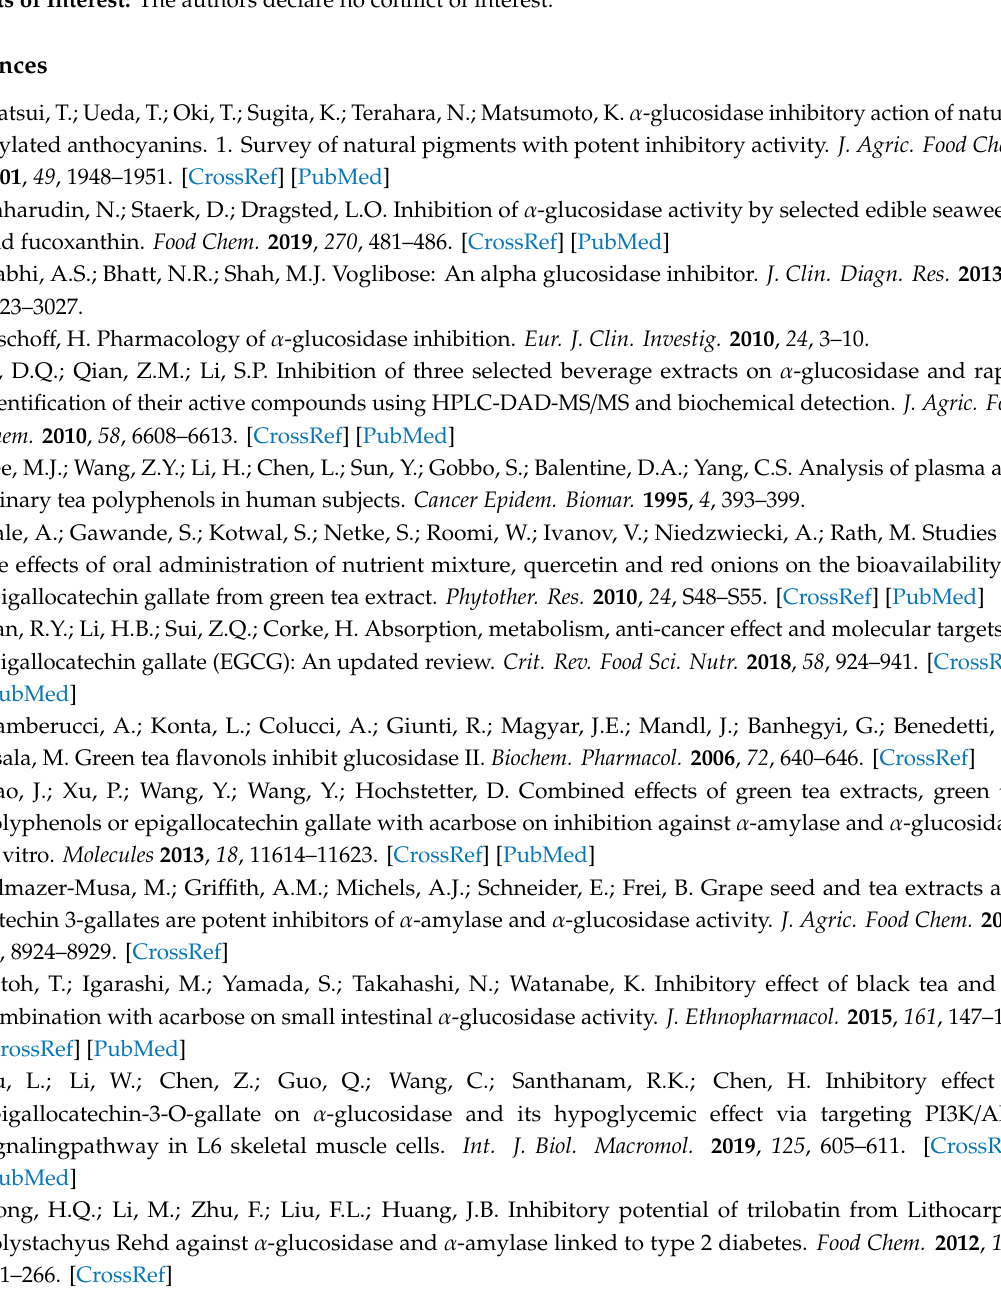
mg · kg − 1 . Supplementary Table S1: Summary of the input parameters used for the PBPK model development. Supplementary Table S2: The true a ffi nity and binding kinetics of acarbose against AGH. Supplementary Table S3: The observed and predicted pharmacokinetics parameters for ECG and EGCG according to PBPK model. Supplementary Table S4: Fasted rat physiological parameters for the intestinal tract. Supplementary Table S5: Fasted human physiological parameters for the intestinal tract. Supplementary Table S6: The observed and predicted pharmacokinetics parameters for acarbose according to PBPK